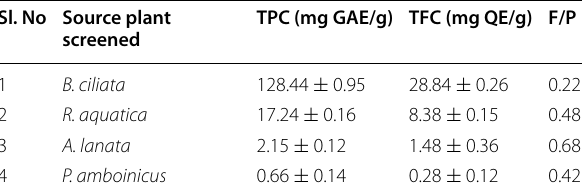
Table 2 Total polyphenolics of various source plants of